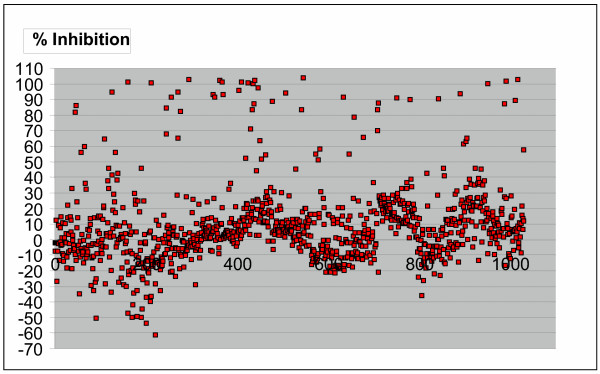
Distribution of potential huntingtin aggregation inhibitors in the NCC library. Most compounds show no or little inhibitory effect on huntingtin aggregation. The potential inhibitors are evenly distributed across the whole chemical library. Due to very high background on particular regions of some dot blotting membranes, some compounds (compounds around 200) show a high apparent promotional effect that is artefactual (as shown in ~-70% inhibition). The 8 compounds located in column 5 of plate 9 were missed and were tested in the second screening at 10 μM.